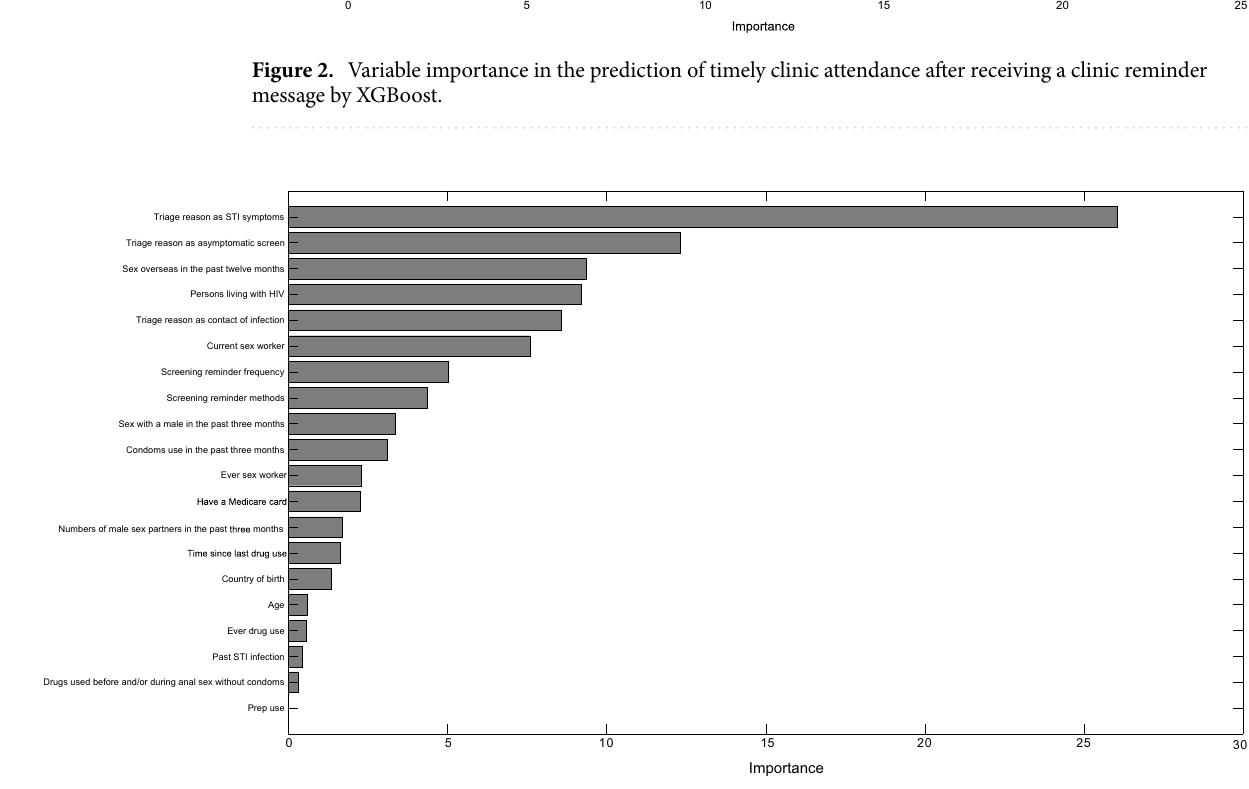
Figure 3. Variable importance in the prediction of timely HIV/STI testing after receiving a clinic reminder message by elastic net